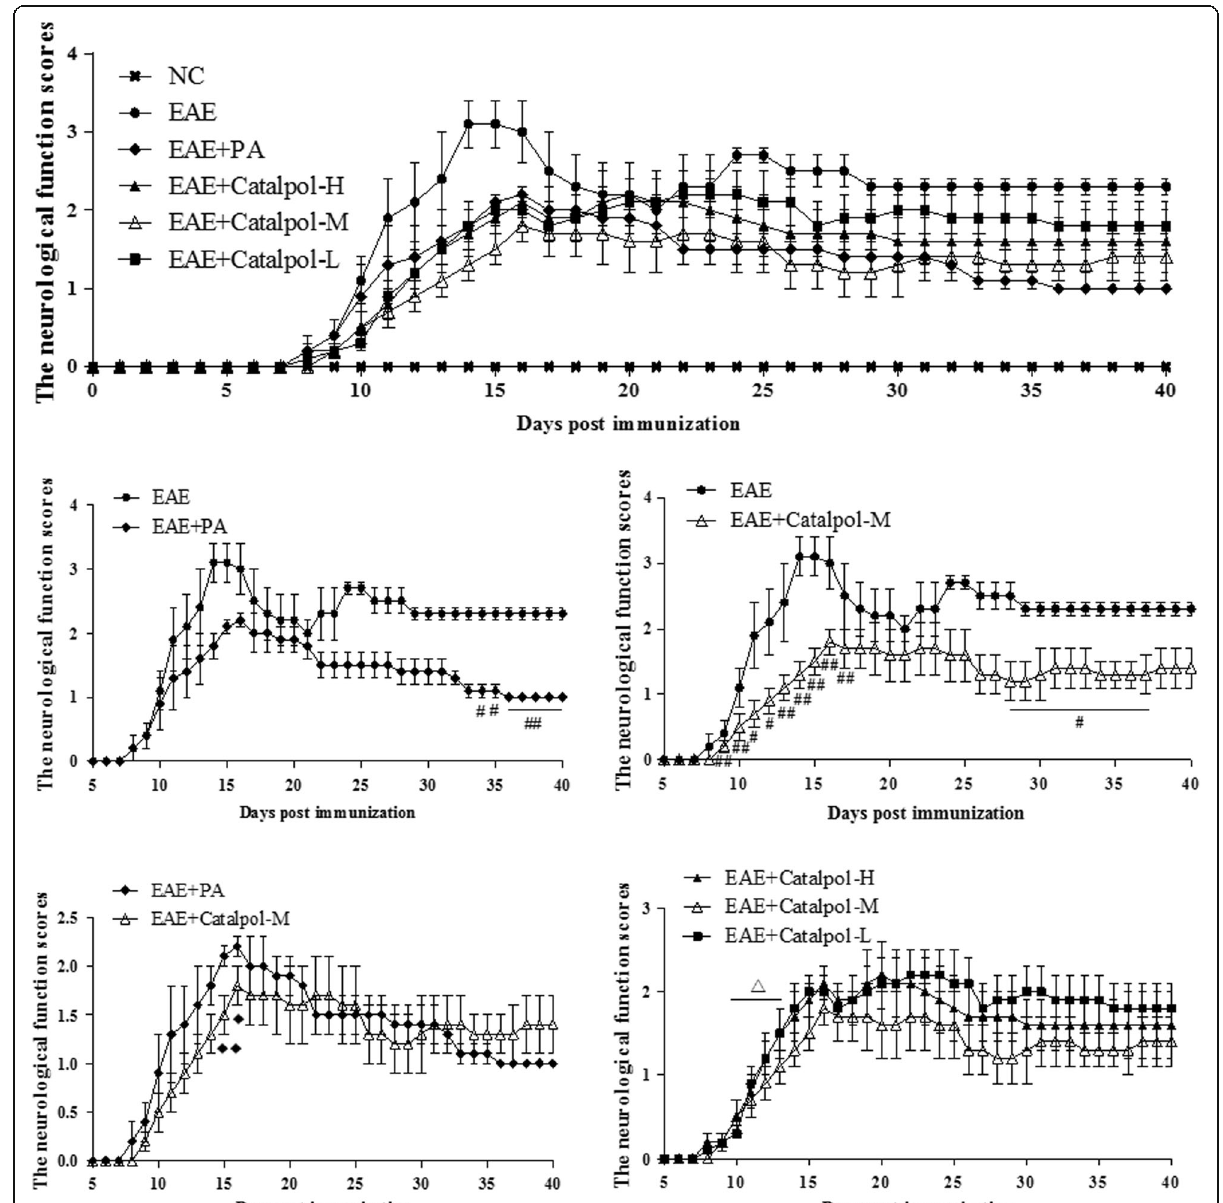
Fig. 1 The neurological function scores of the mice. Results are expressed as means±SE. The PA was given after the disease onset. The mice in the Catalpol treated groups were given oral suspensions of 80 mg/kg, 40 mg/kg, 20 mg/kg respectively once a day for 40 days. The scores were measured in NC (×), EAE ( ● ), EAE+ PA (6 mg/kg, ◆ ), EAE+Catalpol – H (80 mg/kg, ▲ ), EAE+Catalpol – M (40 mg/kg, △ ) and EAE+Catalpol – L (20 mg/kg, ■ ). Note: # P <0.05, ## P <0.01 vs. EAE; ◆ P <0.05, ◆◆ P <0.01 vs. EAE+ PA; △ P <0.05 vs. EAE+Catalpol –